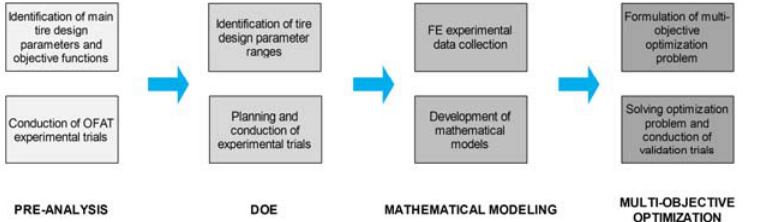
Fig. 3. Applied multi-response optimization